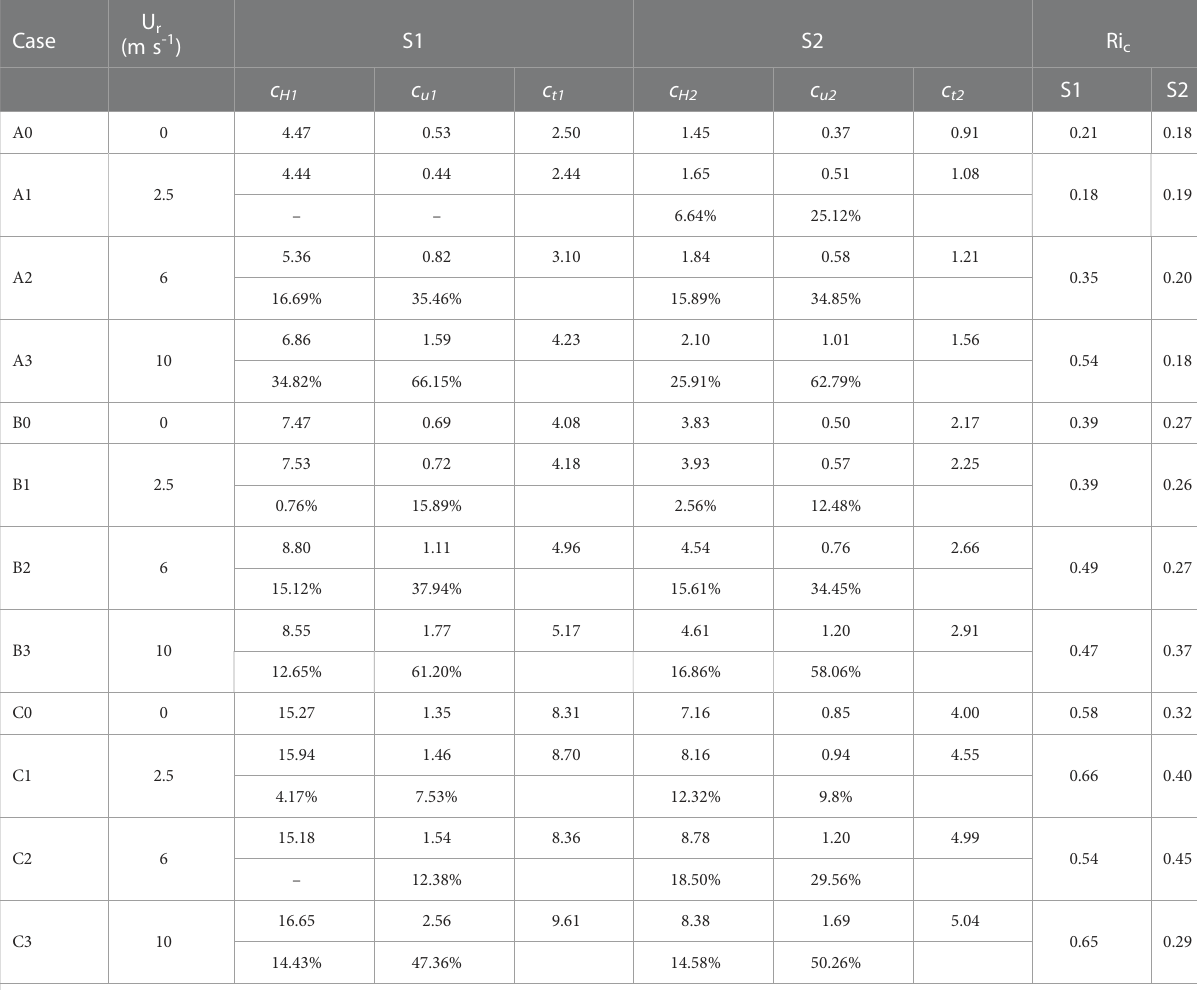
TABLE 2 The vertical-averaged SSC and bulk Richardson number (Ri c ) of the HCL for S1 and S2 under various experimental conditions, respectively.